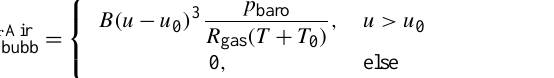
Fig. 4. Top: Amplitude of IAV of the sea–air CO 2 flux es- timated from SOCAT data (run SFC ), calculated as temporal standard deviation (1993–2008) of the interannually filtered flux ( µ mol m − 2 yr − 1 ). Bottom: Capacity of the diagnostic scheme to retrieve interannual variations in the sea–air CO 2 flux from SOCAT v2 data (Reduction of Uncertainty, average performance 1993– 2008). Pixels with RoU < 0 . 2 have been left uncolored.